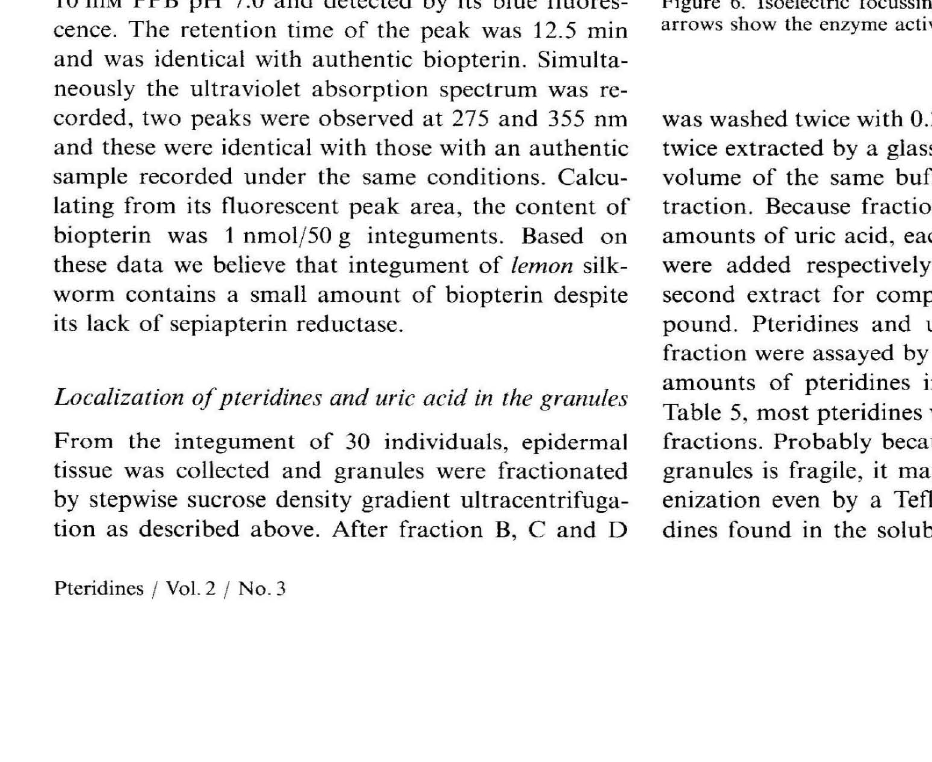
Figure 6. Isoelectric focussing of sepiapterin deaminase. The arrows show the enzyme activity.